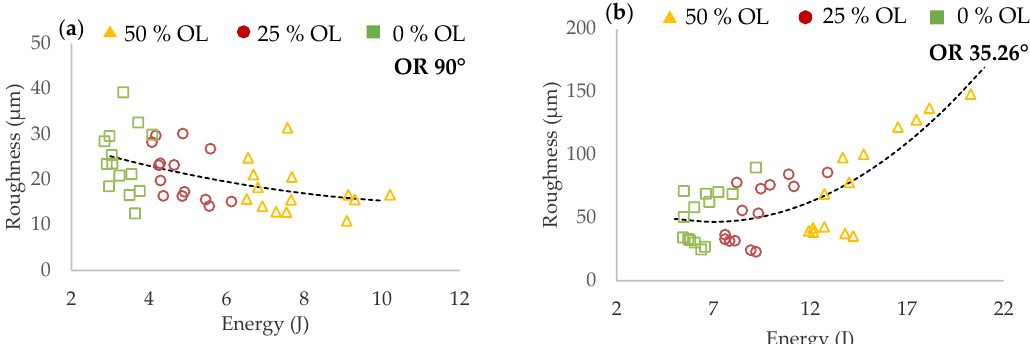
Figure 10. Surface roughness vs. input energy dependence ( a ) for inclination of 90°; ( b ) for inclination of 35.26°.